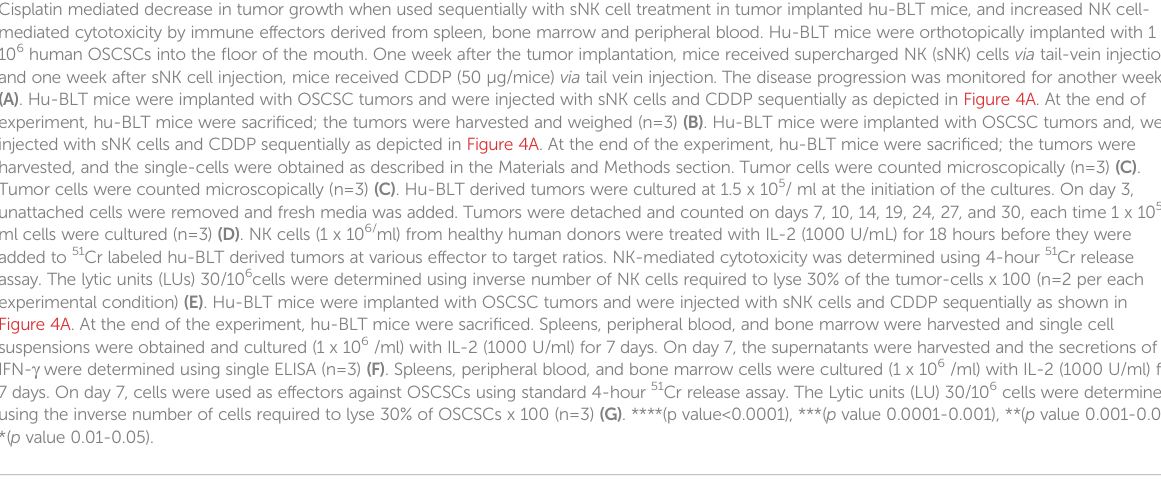
Figure 4A. At the end of the experiment, hu-BLT mice were sacri fi ced. Spleens, peripheral blood, and bone marrow were harvested and single cell suspensions were obtained and cultured (1 x 10 6 /ml) with IL-2 (1000 U/ml) for 7 days. On day 7, the supernatants were harvested and the secretions of IFN- g were determined using single ELISA (n=3) (F) . Spleens, peripheral blood, and bone marrow cells were cultured (1 x 10 6 /ml) with IL-2 (1000 U/ml) for 7 days. On day 7, cells were used as effectors against OSCSCs using standard 4-hour 51 Cr release assay. The Lytic units (LU) 30/10 6 cells were determined using the inverse number of cells required to lyse 30% of OSCSCs x 100 (n=3) (G) . ****(p value<0.0001), ***( p value 0.0001-0.001), **( p value 0.001-0.01), *( p value